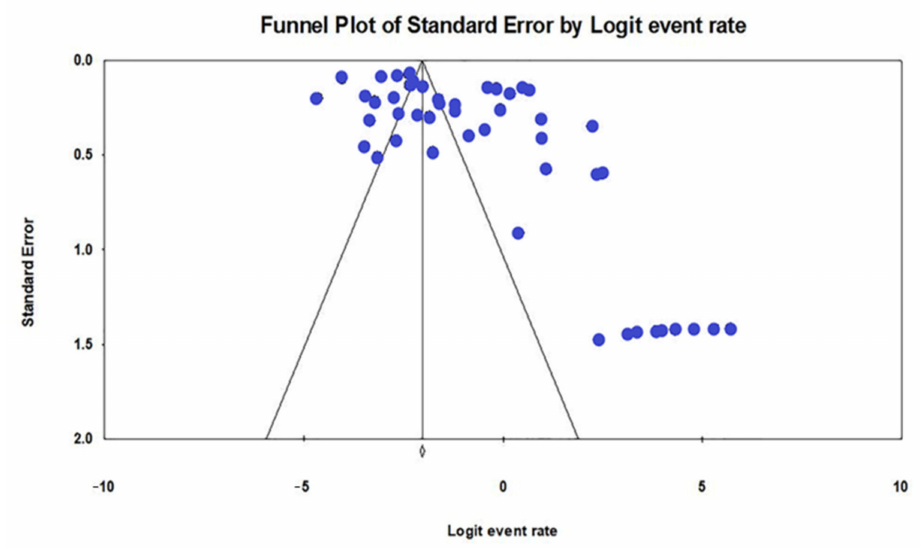
Figure 4. Funnel plot showing the evidence of publication bias with Egger’s test ( p -value <